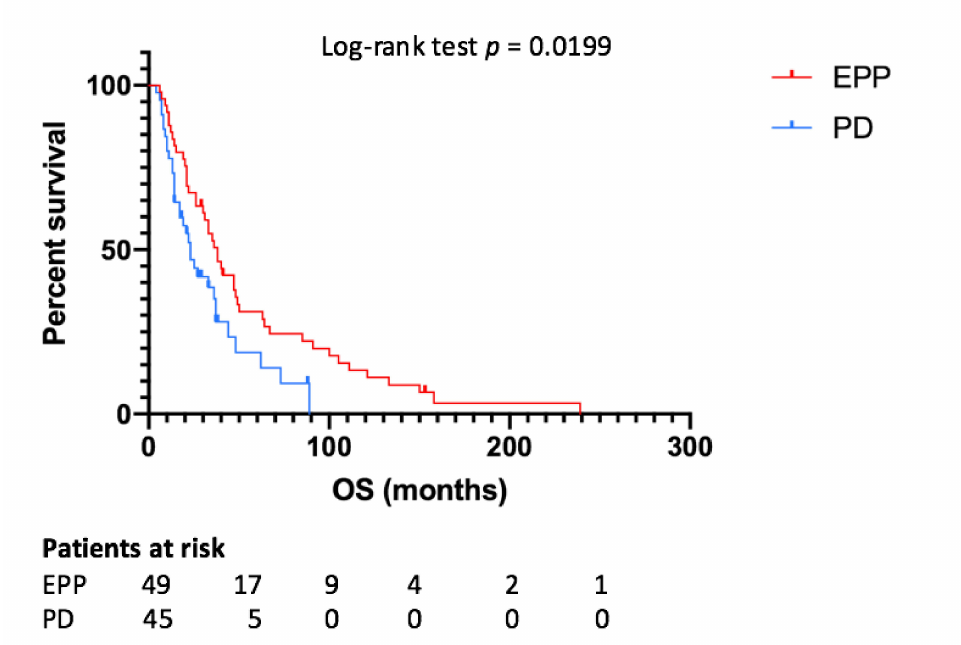
Figure 2. Overall survival depending on type of surgery. EPP—extrapleural pneumonectomy; PD—pleurectomy/ decortication; OS—overall